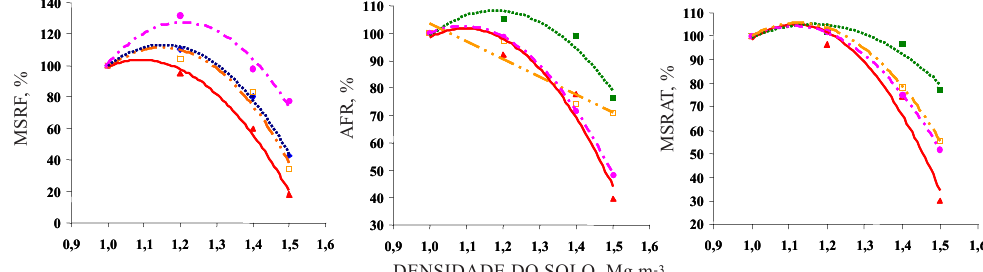
Figura 3. Massa seca relativa de frutificação (MSRF), área foliar relativa (AFR) e massa seca relativa total da parte aérea (MSRAT) de plantas de soja ( ), milho ( ), algodoeiro ( ) e Brachiaria brizantha ( ), considerando a compactação em Latossolo Vermelho-Escuro